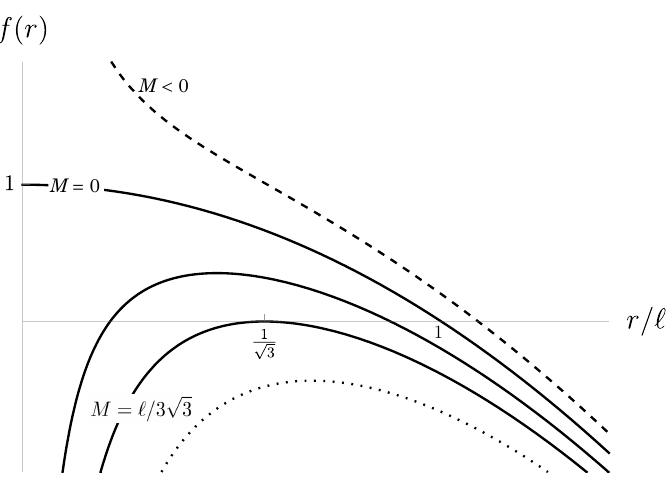
Figure 1. The function f ( r ) for different values of the mass parameter. Real solutions for r 0 (and therefore for the Riemannian spatial metric) exist only where f ( r ) ≥ 0 , and a horizon can only exist where f ( r ) = 0